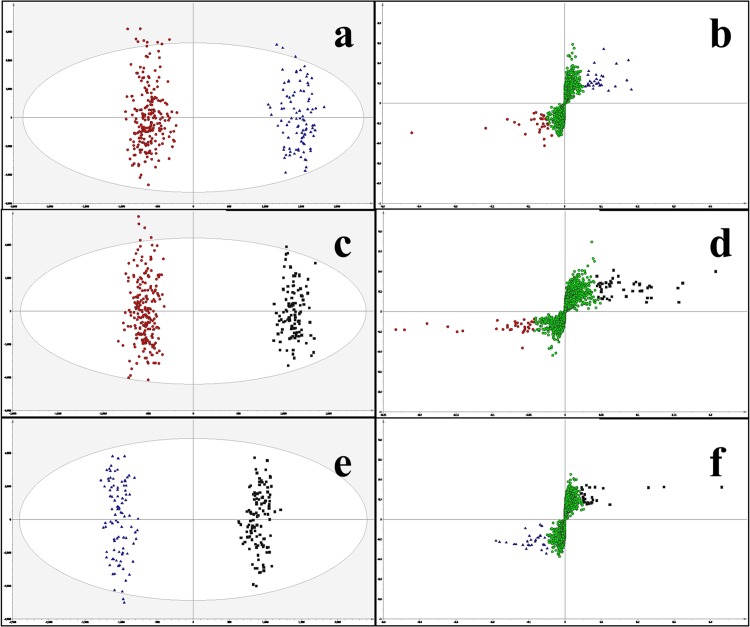
Multivariate models comparing groups and s-plots indicating the ‘ions of interest’.Groups were compared in pairs with Controls (red circles), MCI (black squares) and MCI_AD (blue triangles) indicated on OPLS-DA scores plots (Fig. 2A, 2C and 2E). (a) Ctrl vs. MCI; R2 = 97.6%; Q2 = 95.3%; (c) Ctrl vs. MCI_AD; R2 = 98.4%; Q2 = 95.7%. (f) MCI vs. MCI_AD; R2 = 98.7%; Q2 = 95.8%. Corresponding s-plots (Fig. 2B, 2D and F) highlight which ions are up or down regulated in their respective group as represented by the colour and shape of the variables.